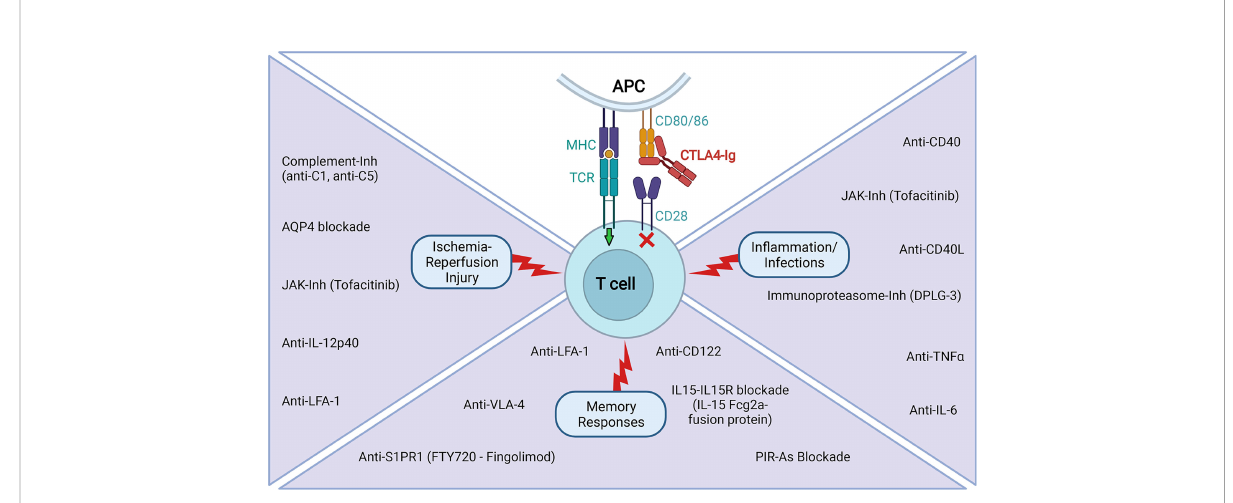
FIGURE 2 Tested experimental strategies to improve CTLA4-Ig ef fi cacy in extending transplant survival. The reported use of agents that limit the contribution of signal 3 on T cell activation in situations of IRI, in fl ammation and infections, and pre-existence of memory responses that has proven to be ef fi cacious in combination with CTLA4-Ig in extending transplant survival in various experimental settings (Created with BioRender.com).